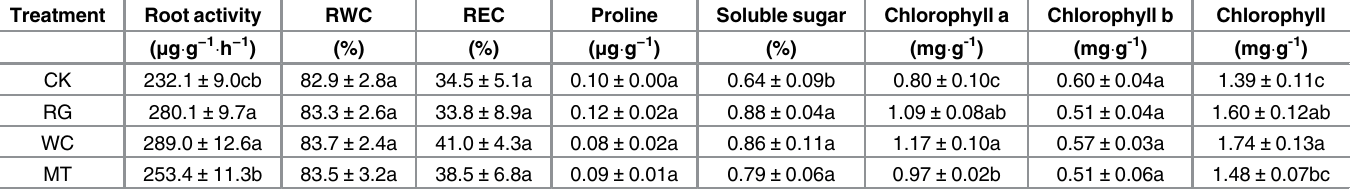
Table 4. Physiological features of plants measured on May 23, 2014 in bare soil (CK) or soils treated with round gravel (RG), wood chips (WC), and manila turf grass (MG). Treatment Root